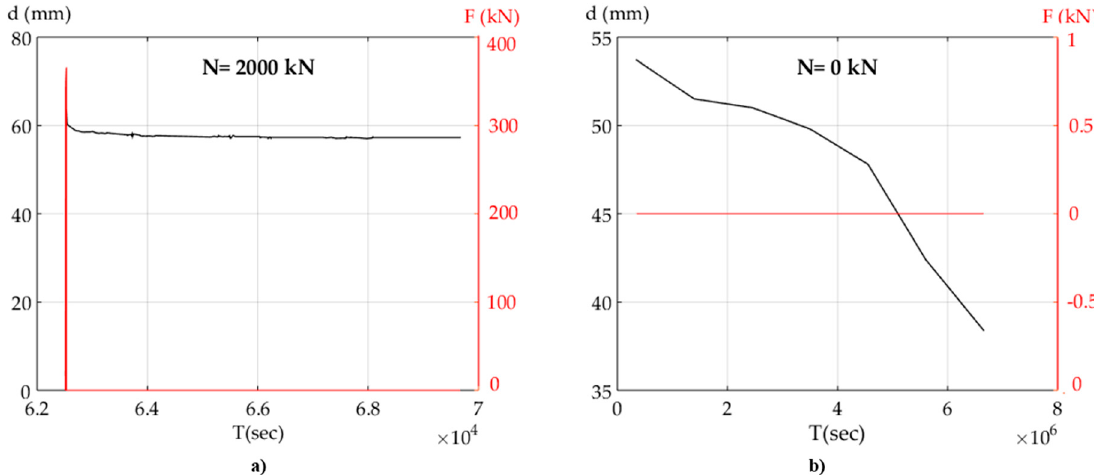
Figure 24. A Relaxation test [49] carried out on a real-scale LRB specimen: imposed force F ( t ) and displacement d ( t ) time histories for, ( a ) 62.4 ≤ t ≤ 69.4 ksec and constant value of applied axial load N Sd = 2000 kN and for, ( b ) 76.87 ksec ≤ t ≤ 6.65 Msec and vanished axial load N Sd = 0.0 kN (data from